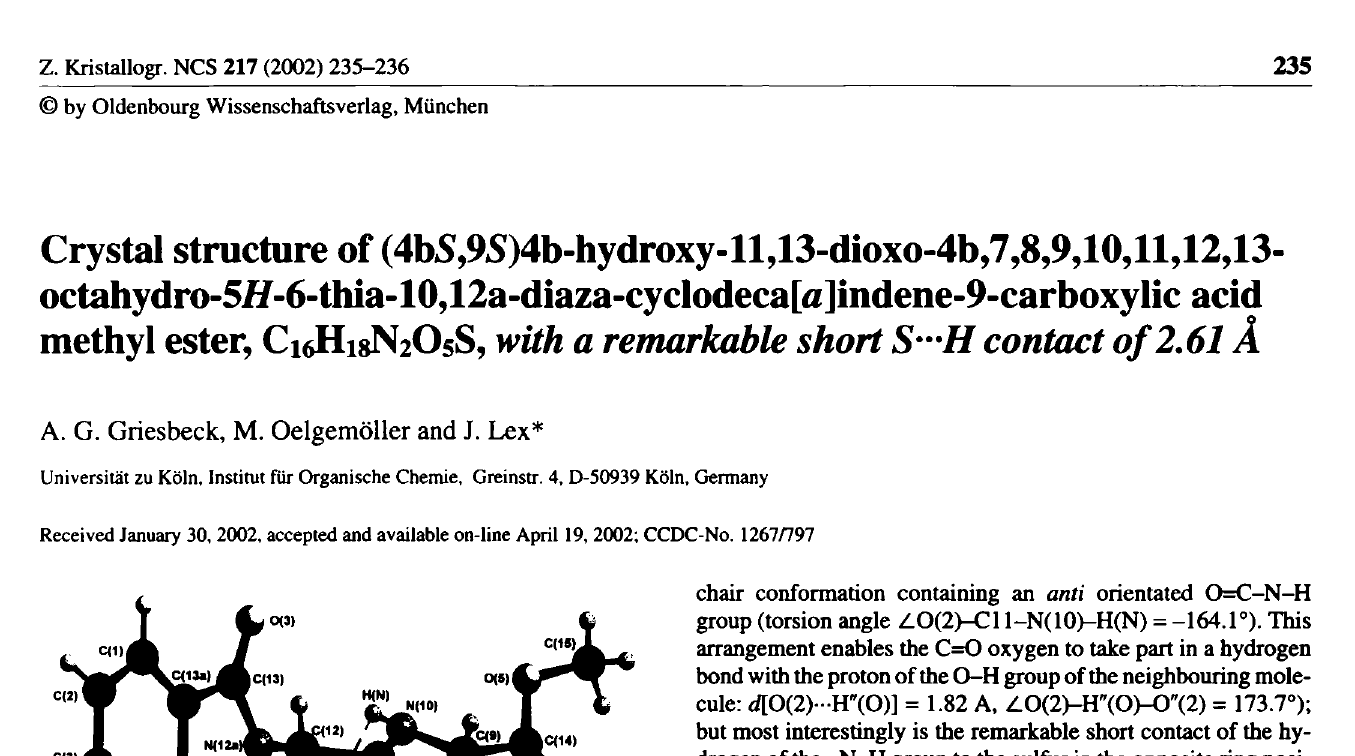
Table 1. Data collection and handling.